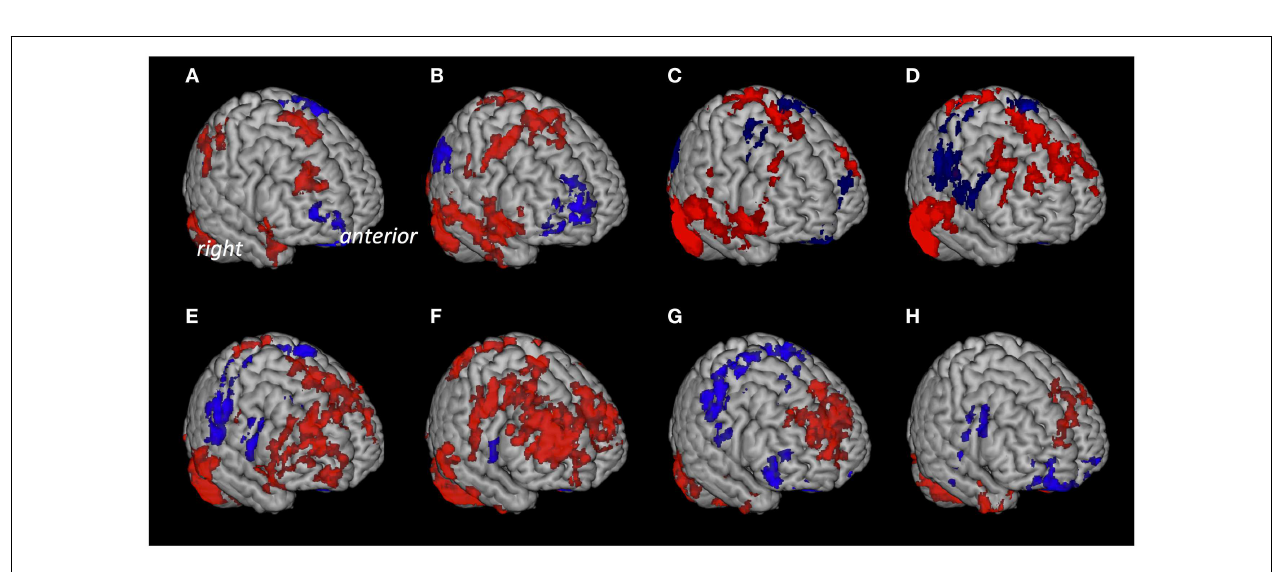
FIGURE 2 | Cerebral voxels with significant coupling to the respective seeds at rest . Areas with “positive” connectivity are indicated in red, “negative” connectivity in blue: (A) Seed #1 (cerebellar lobules I–V),